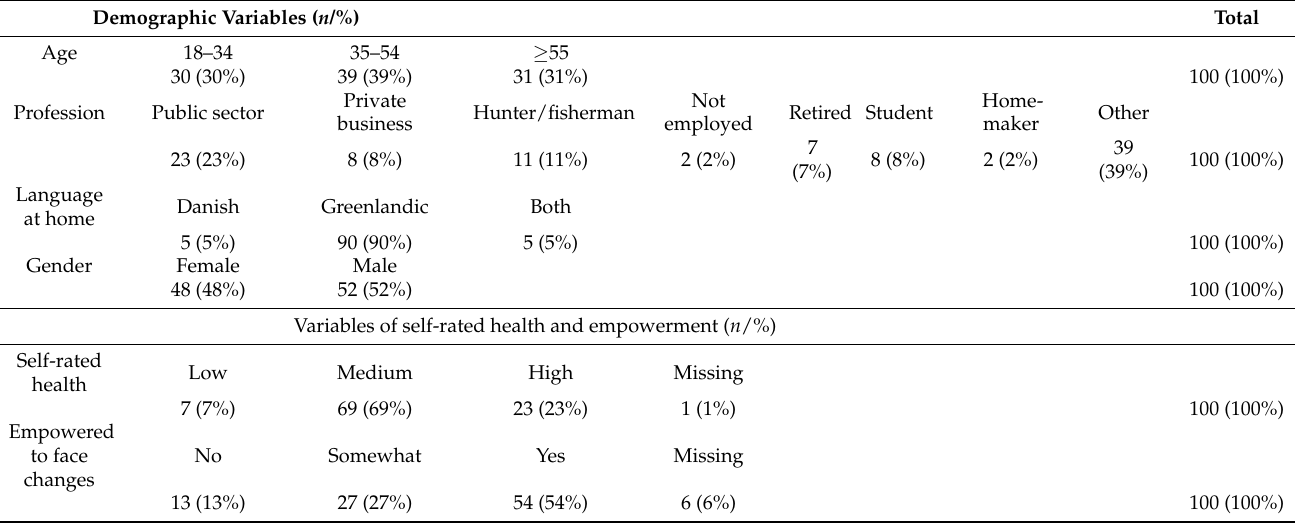
Table 1. Demographic